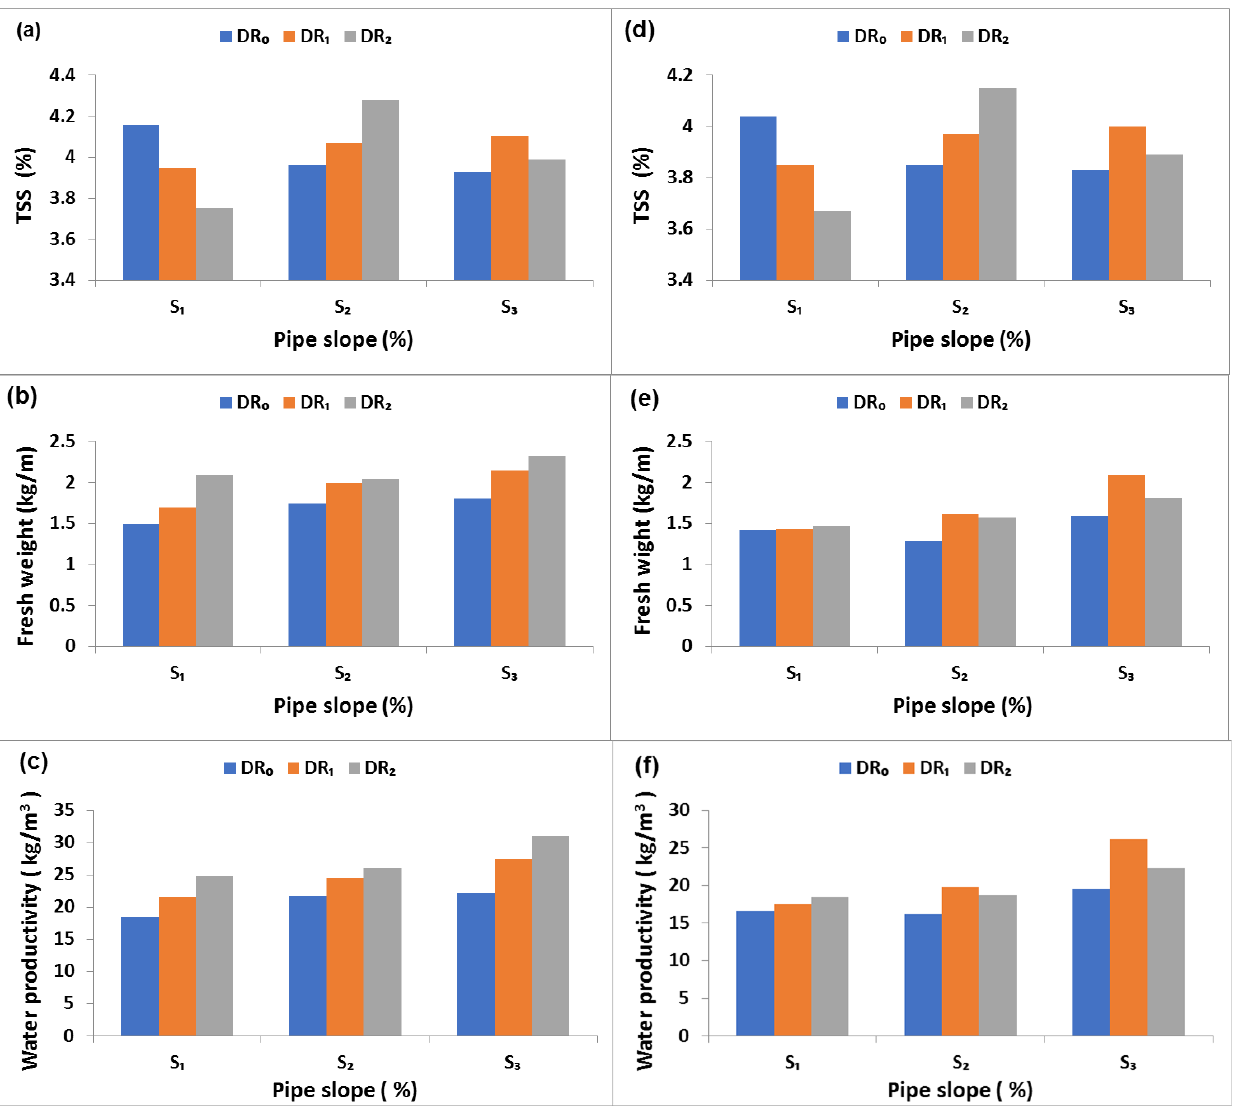
Figure 4. Interaction between pipe slope and depletion ratio on ( a , d ) total soluble solids (TSS), ( b , e ) fresh weight and ( c , f ) water productivity of lemur and 077 cultivars, respectively. DR 0 , DR 1 and DR 2 refer to depletion ratio at 50%, 60% and 70%, respectively. S 1 , S 2 and S 3 refer to pipe slope at 0.000%, 0.025% and 0.075%, respectively.